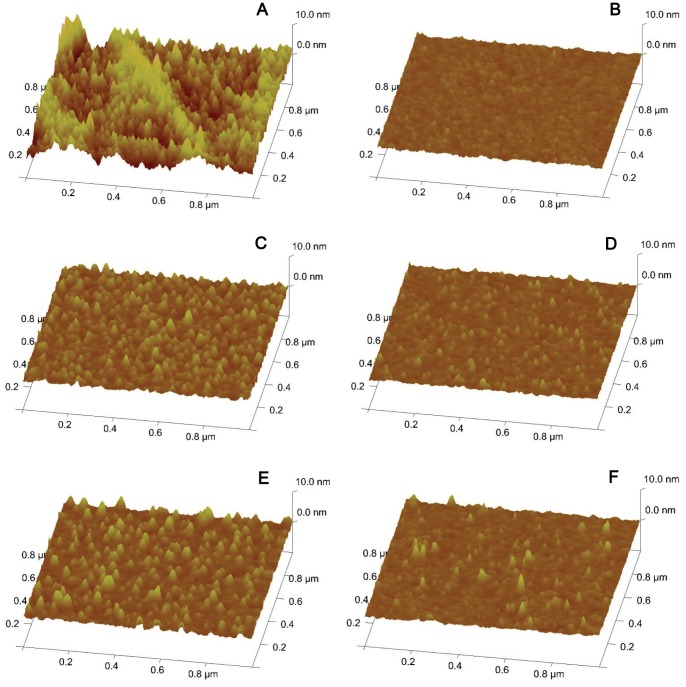
Surface structure analysis of an Si3N4 surface under different coating conditions.Three-dimensional atomic force microscope height images. (A) 0.01% poly-L-lysine coated plastic dish, (B) non-coated Si3N4 surface, (C) 0.01% poly-L-lysine coated Si3N4 surface at 1 day after coating and (D) at 5 days after coating, (E) 0.05% poly-L-lysine coated Si3N4 surface at 1 day after coating and (F) at 5 days after coating.